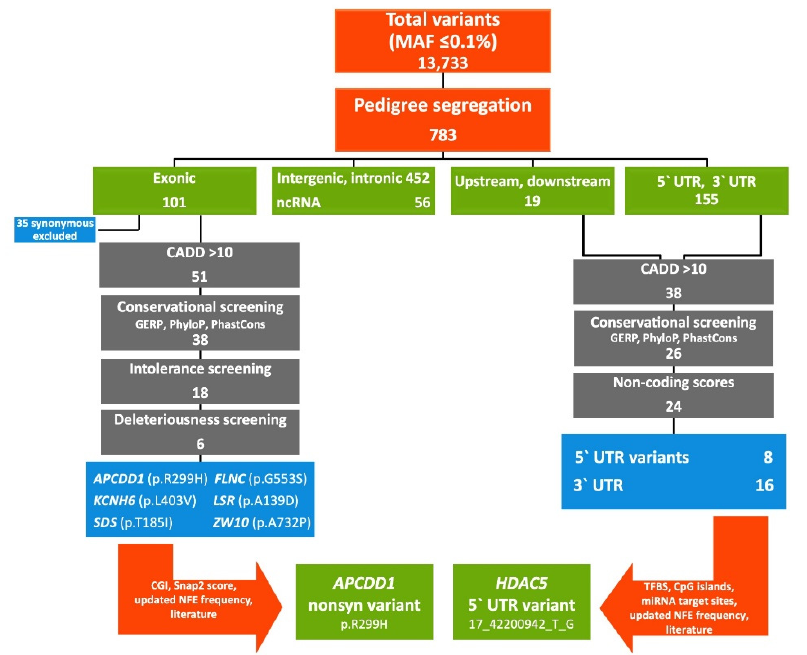
Figure 2. Graphical representation of the filtering process according to the Familial Cancer Variant Prioritization Pipeline version 2 (FCVPPv2).